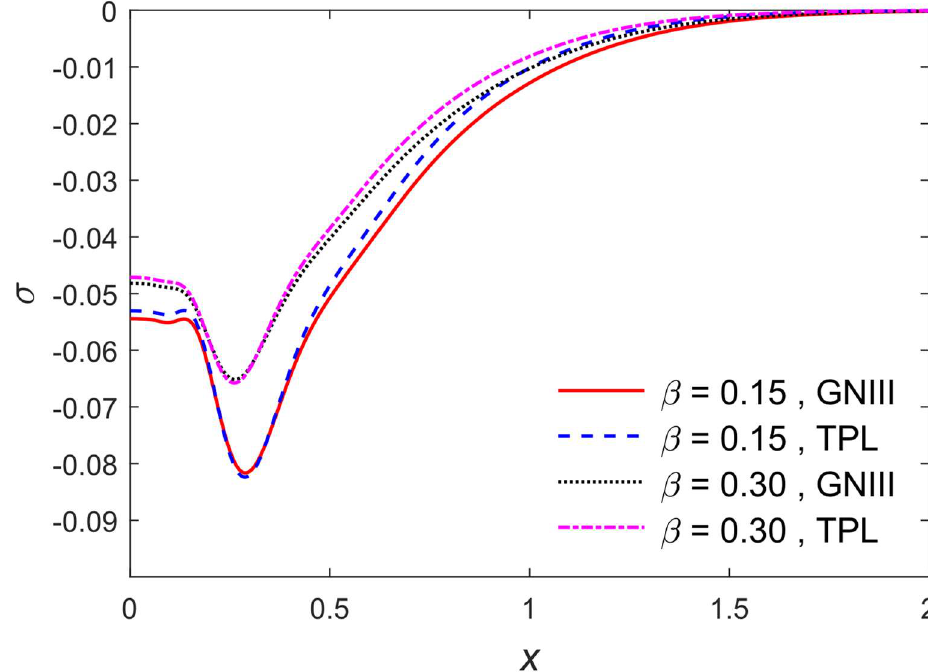
Figure 7. The distributions of fluid stress σ along the distance 𝑥 .